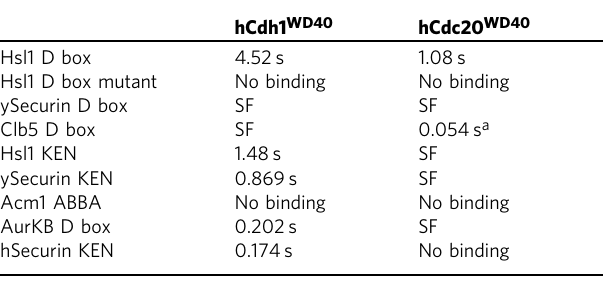
Dwell times are representative of two independent replicates, listed in Supplementary Table 1. SF single frame. a Calculated dwell time is less than three times the frame rate and is, therefore, less